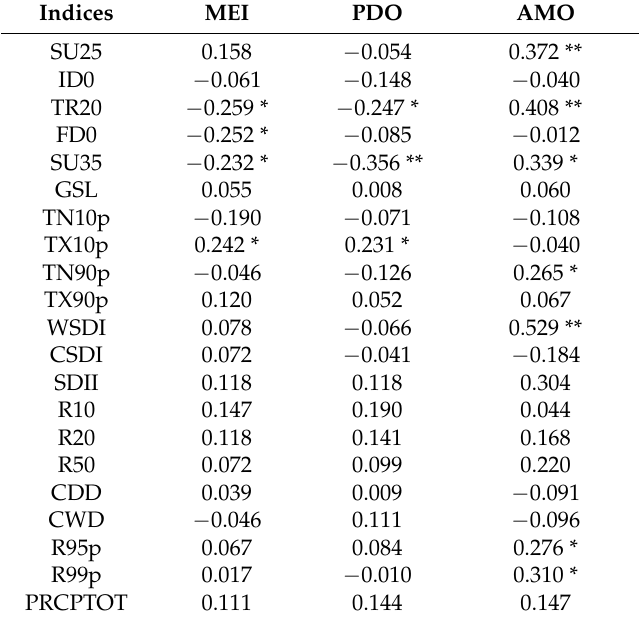
Table 4. Correlation coefficients between climatic indicators for the whole study area and circulation modes of climate variability during